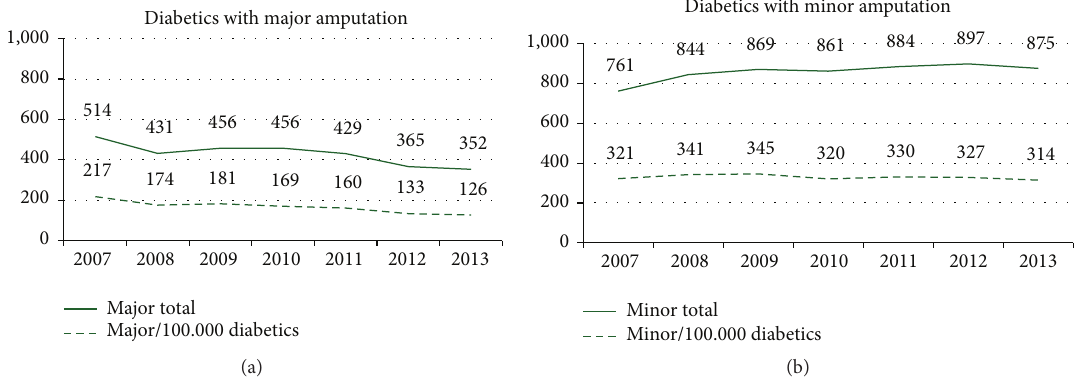
Figure 3: Number of diabetics with major or minor amputation,